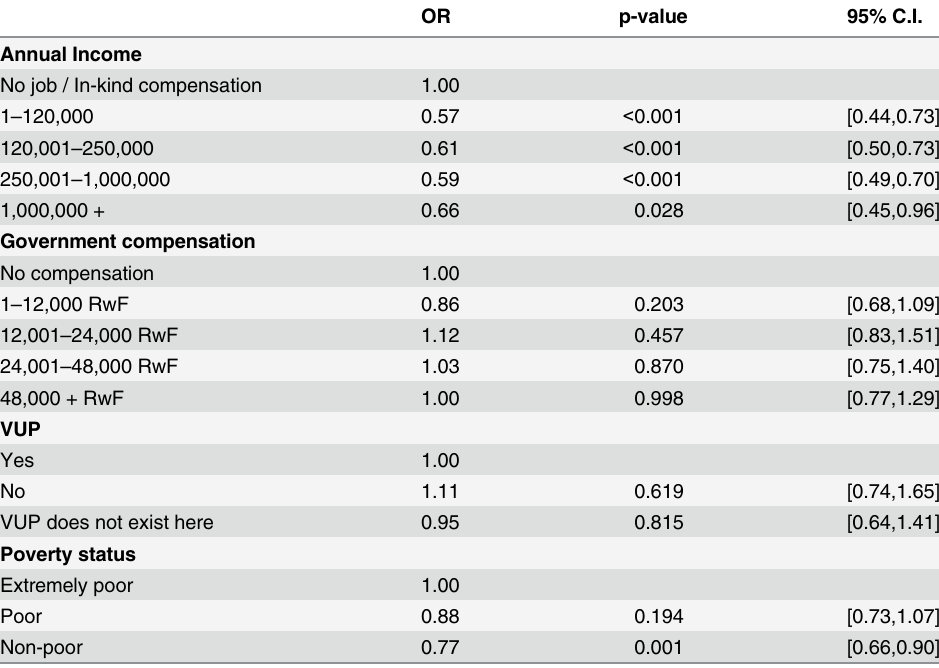
Table 3. Multivariate Logistic Regression Model With Odds Ratio, P-Value and Confidence Interval of People with Self Reported Major Disability * . OR p-value 95%